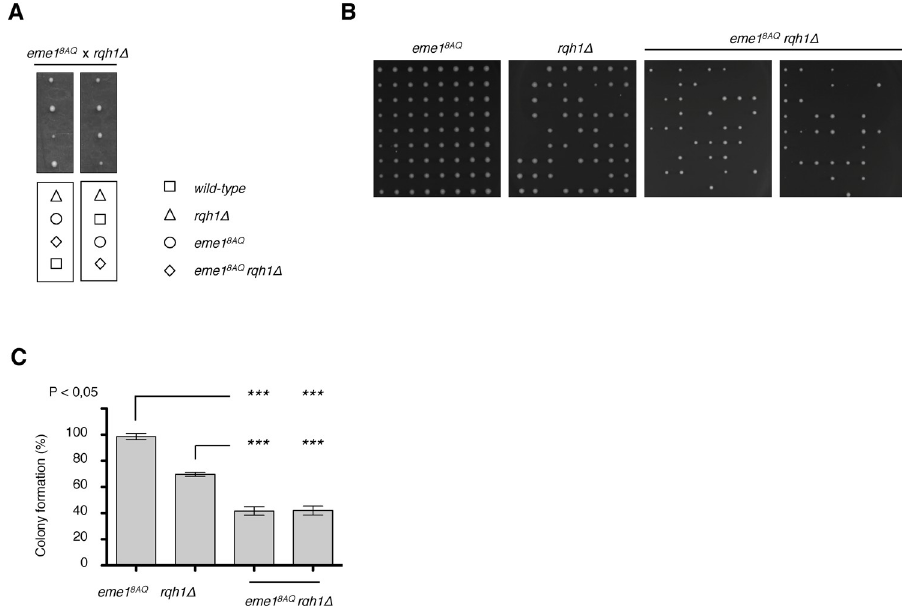
Fig 3. Negative genetic interaction between eme1 8AQ and rqh1 Δ . A- Tetrad analysis of an eme1 8AQ x rqh1 Δ mating, germinated at 30˚C. Boxes below dissections indicate the genotypes of each spore. B- Exponentially growing eme1 8AQ , rqh1 Δ and eme1 8AQ rqh1 Δ cells were seeded on YES plates by micromanipulation and allowed to grow for 3 days at 32˚C. C- Average percentage ( ± s.d.) of viable colonies (n = 3 independent experiments). Statistical significance is measured with one-way ANOVA followed by Tuckey